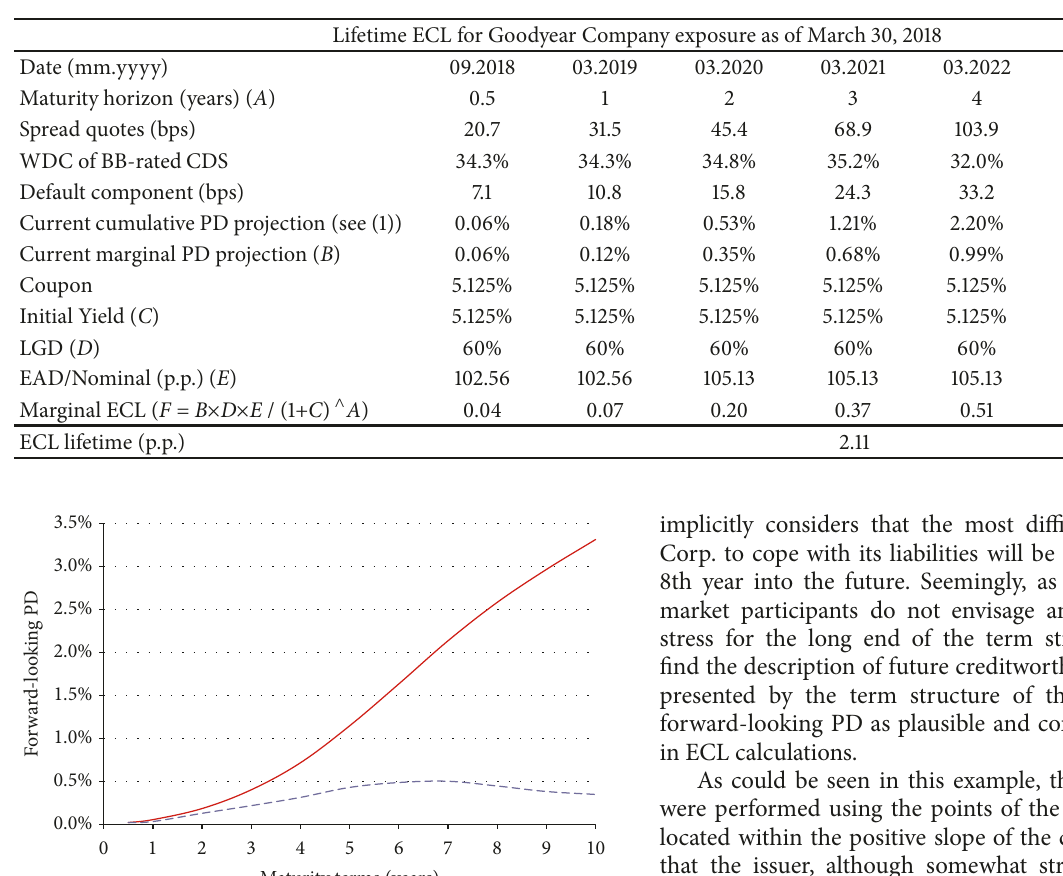
Table 3: Lifetime ECL for the bond of the Goodyear Company as of March 30, 2018.